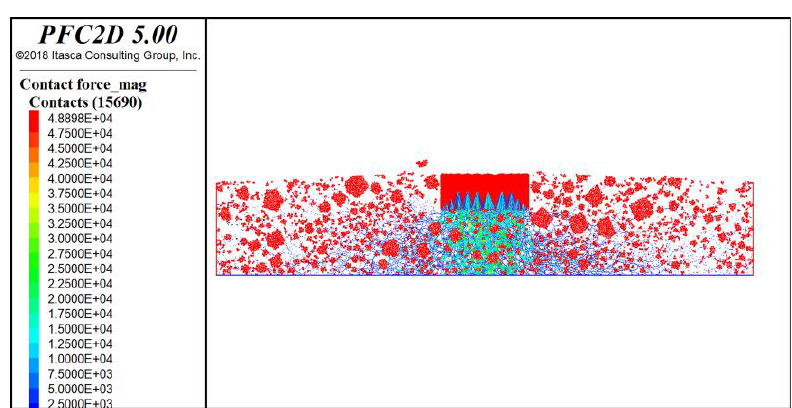
Figure 12. Displacement vector of particles.